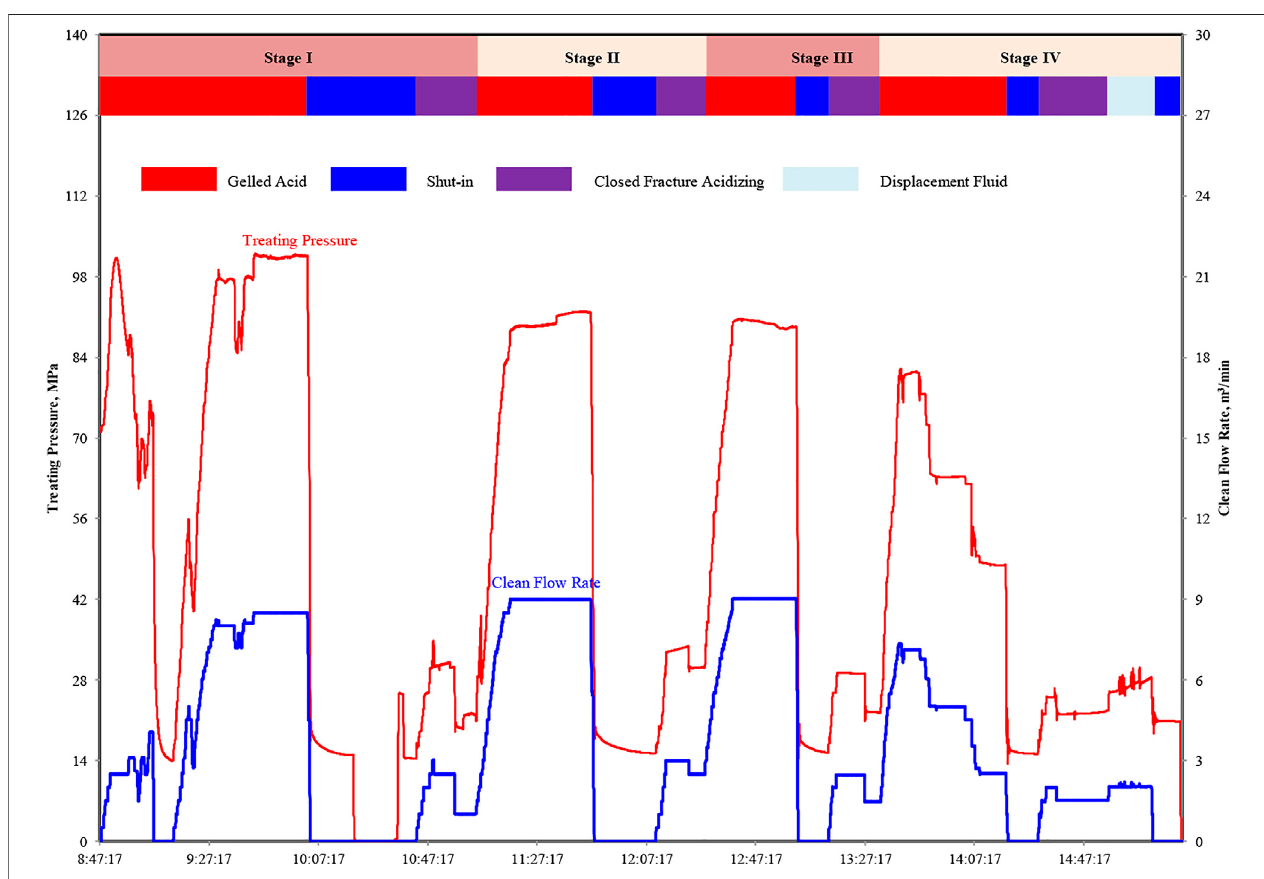
FIGURE 15 | Staged acid fracturing with the closed fracture acidizing operation curve of well M.